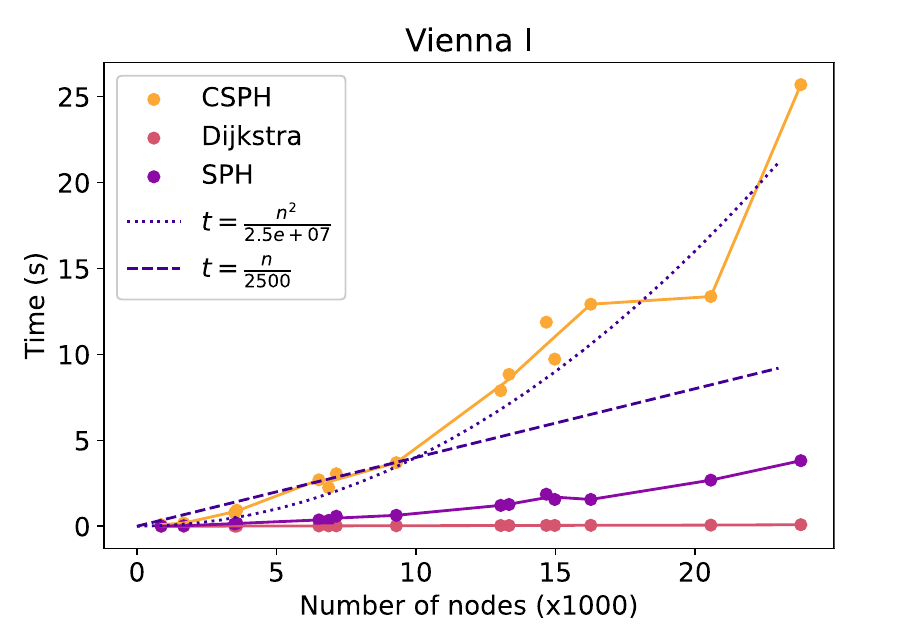
Fig 7. Vienna I time evolution by method. Evolution of the time cost of Dijkstra, SPH and CSPH. Includes a quadratic and linear function to compare trends.